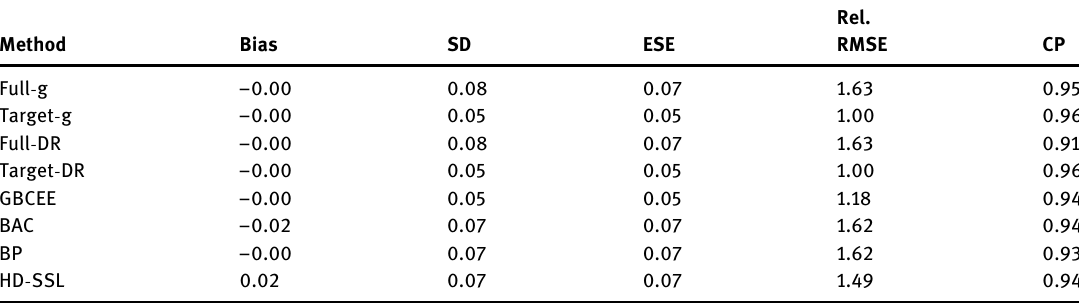
Table A7: Results of Scenario 2C ( continuous exposure, continuous outcome ) with n 1,000 =